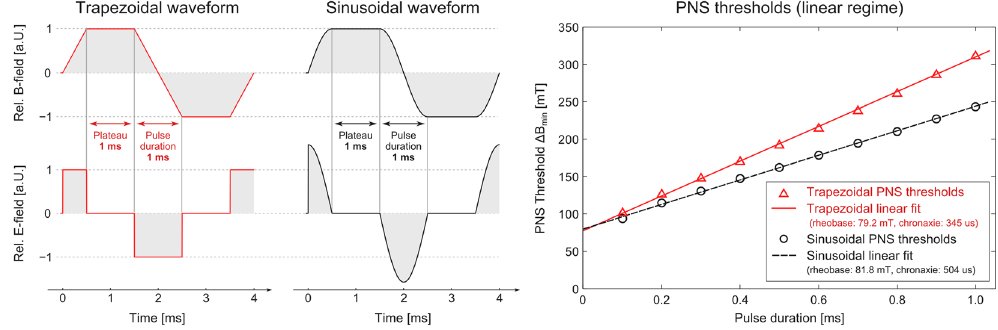
Figure 10. Trapezoidal and sinusoidal B-field waveforms and the resulting E-field pulses (plateau duration 1.0 ms, pulse durations between 0.1 and 1.0 ms, overall 10 bipolar pulses) and the resulting PNS thresholds as a function of pulse duration (i.e., in the linear